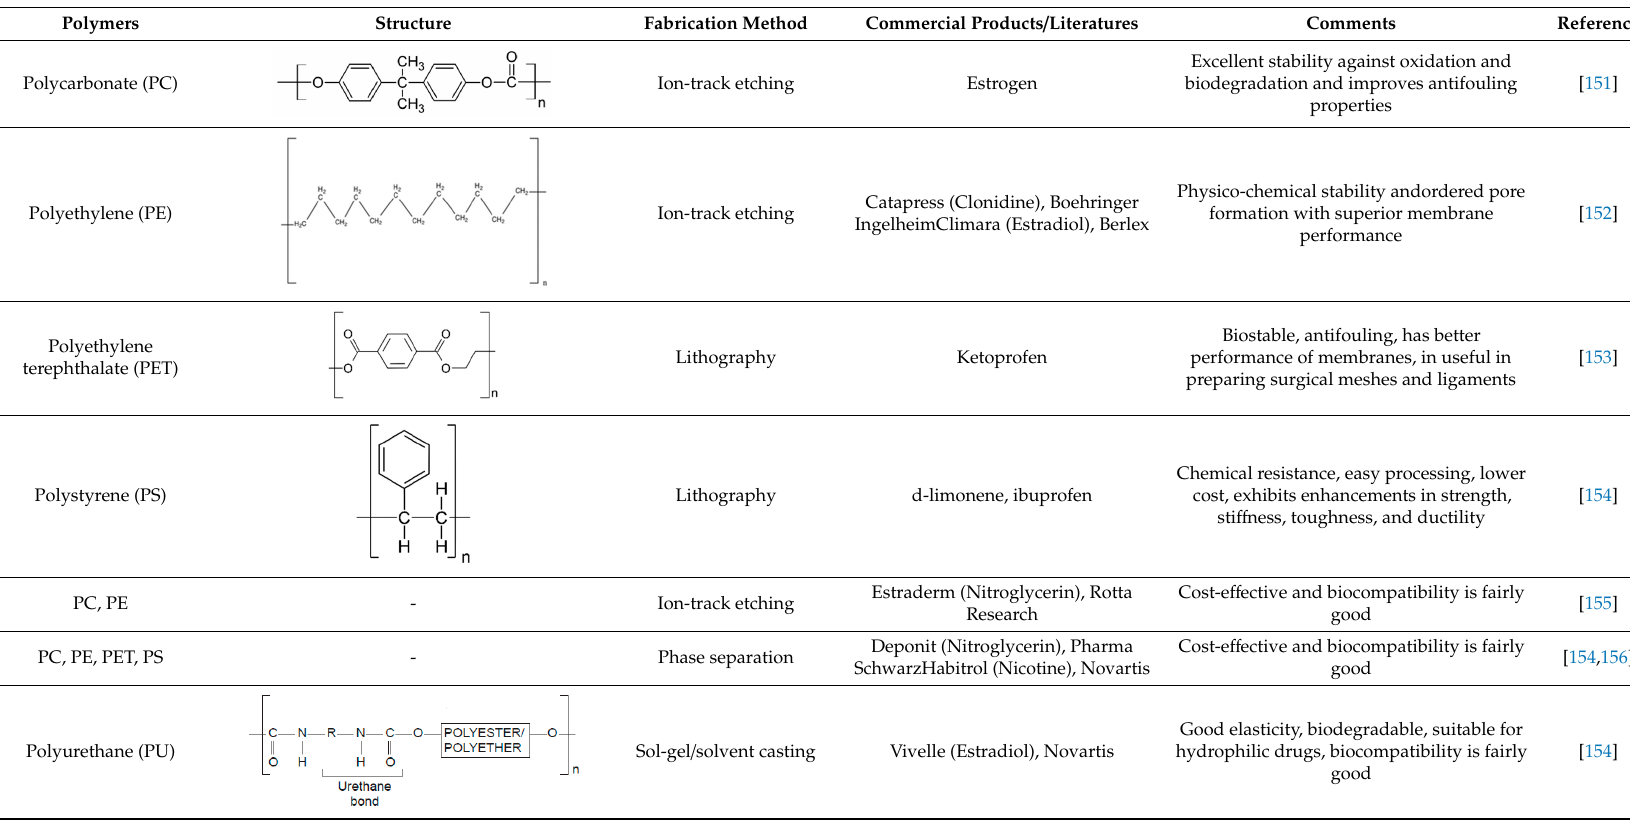
Table 2. Various formulations of drug delivery systems emphasizing the physico-chemical and mechanical properties of various polymers being used in commercially available membrane drug delivery systems.